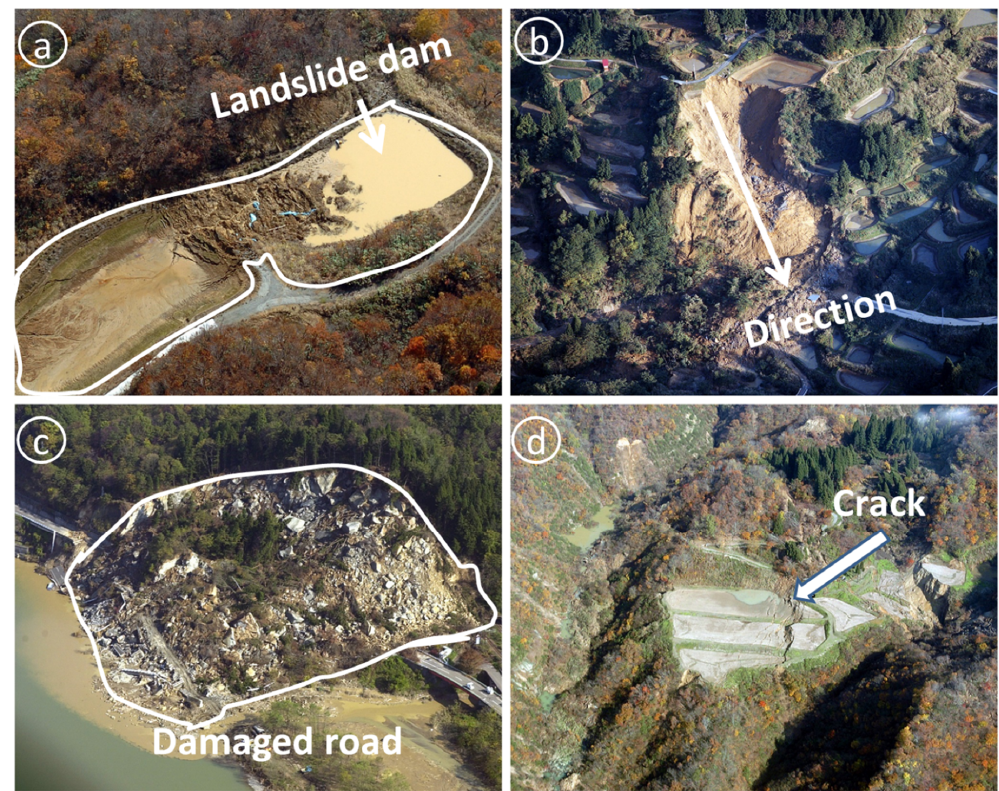
Figure 2. Illustrating the characteristics and different types of landslides in the study area: ( a ) shallow spread in the north of the Hitotsuminesawa with water, Nagaoka city; ( b ) rotational soil slide in north of Mushigame; ( c ) bedrock collapse severely destroyed the road in Nagaoka; ( d ) translational slide, an arrow display secondary scarp in the Uonuma city (Images provided by NIED).